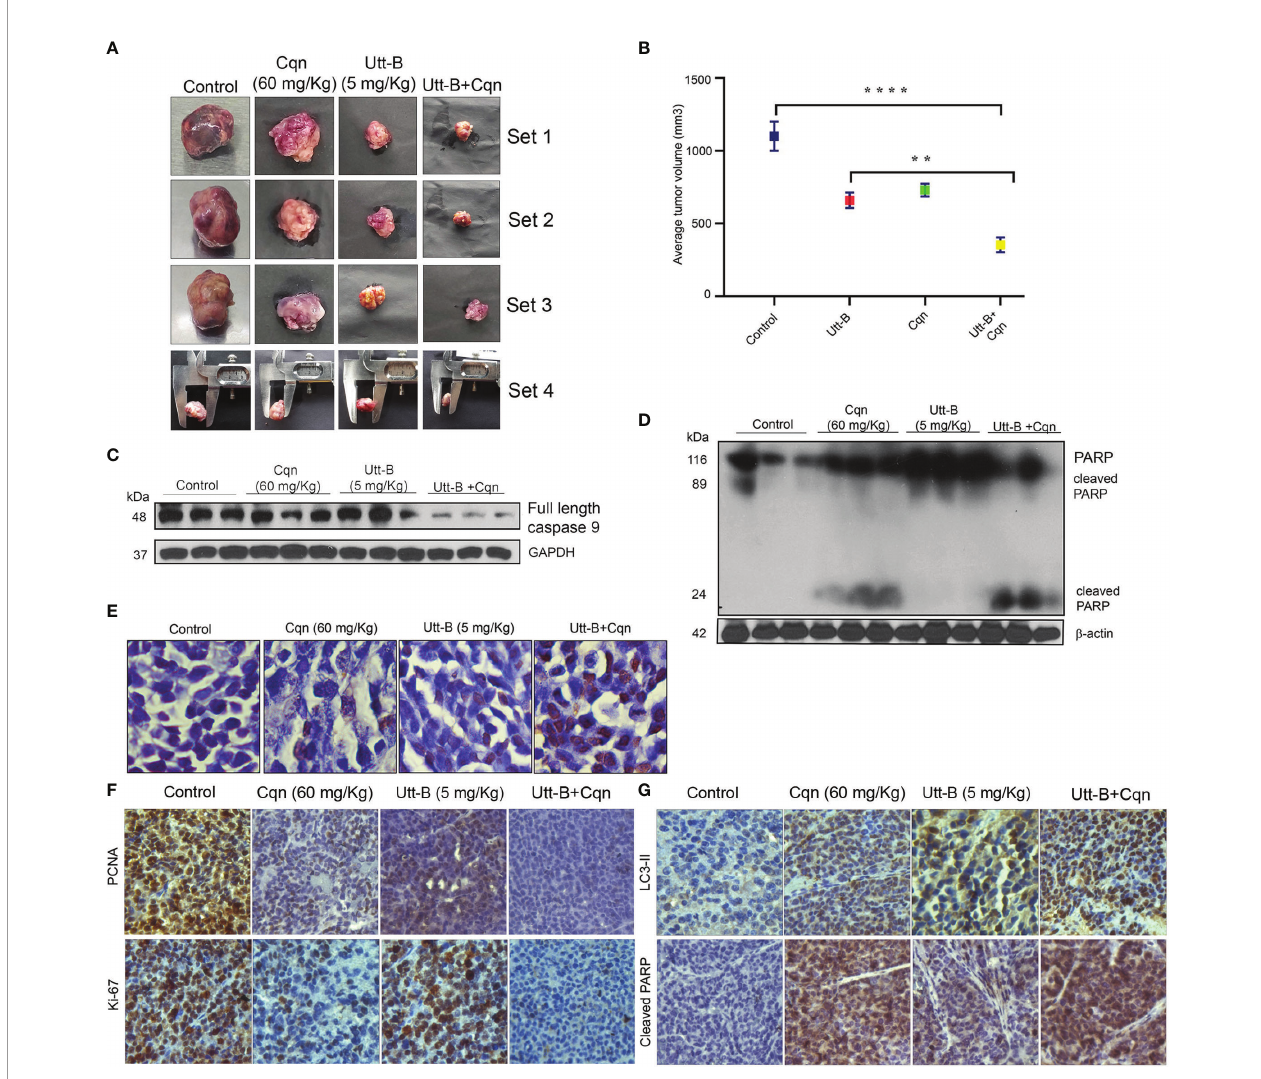
FIGURE 6 | Co-treatment of Cqn enhances the antitumor ef fi cacy of Utt-B against HCC, in NOD-SCID mice bearing HepG2 xenografts. (A, B) Tumor images and Graphical representation of fi nal tumor volume of different groups. (C, D) Western blot analysis demonstrating enhanced cleavage of caspase 9 motherband and PARP in the group co-treated with Cqn and Utt-B, compared to control and individual treatments. (E) Increase in TUNEL-positive cells in the group co-treated with Cqn and Utt-B, con fi rming enhancement in apoptosis (F, G) Immunohistochemical analysis of nuclear proliferation markers PCNA, ki67 and the autophagy marker LC3-II and Apoptotic marker Cleaved PARP. ** level of signi fi cance 2, **** level of signi fi cance 4. Data represent three independent sets of experiments. The error bars represent the Standard Deviation. Statistical signi fi cance was analysed by Student ’ s t test. ****P ≤ 0.0001; **P ≤ 0.01. Symbol asterisk (*) represents statistical signi fi cance between control and treatment groups (B)